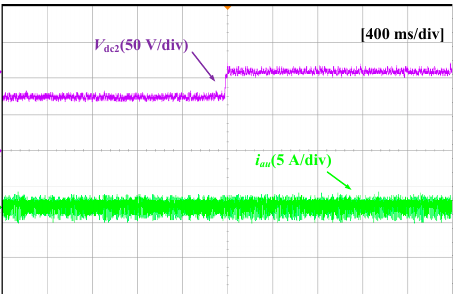
Figure 20. The DC output voltage and arm current of the proposed DC-DC MMC with a step voltage change from 80 V to 120 V.